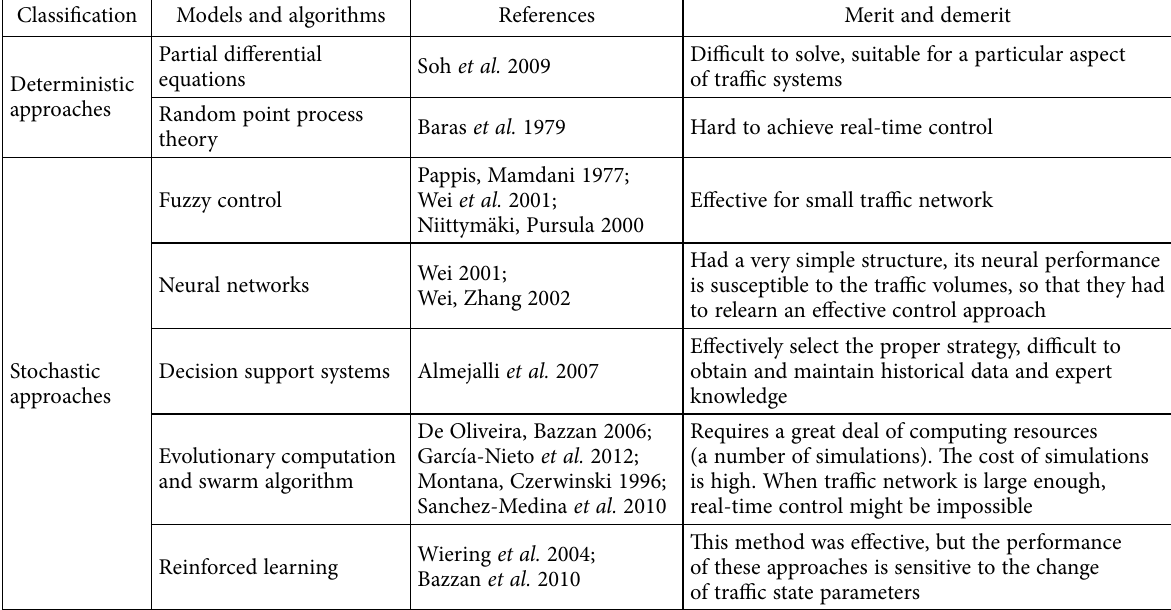
Table 1. The merits and demerits of the typical models and algorithms for traffic signal fields